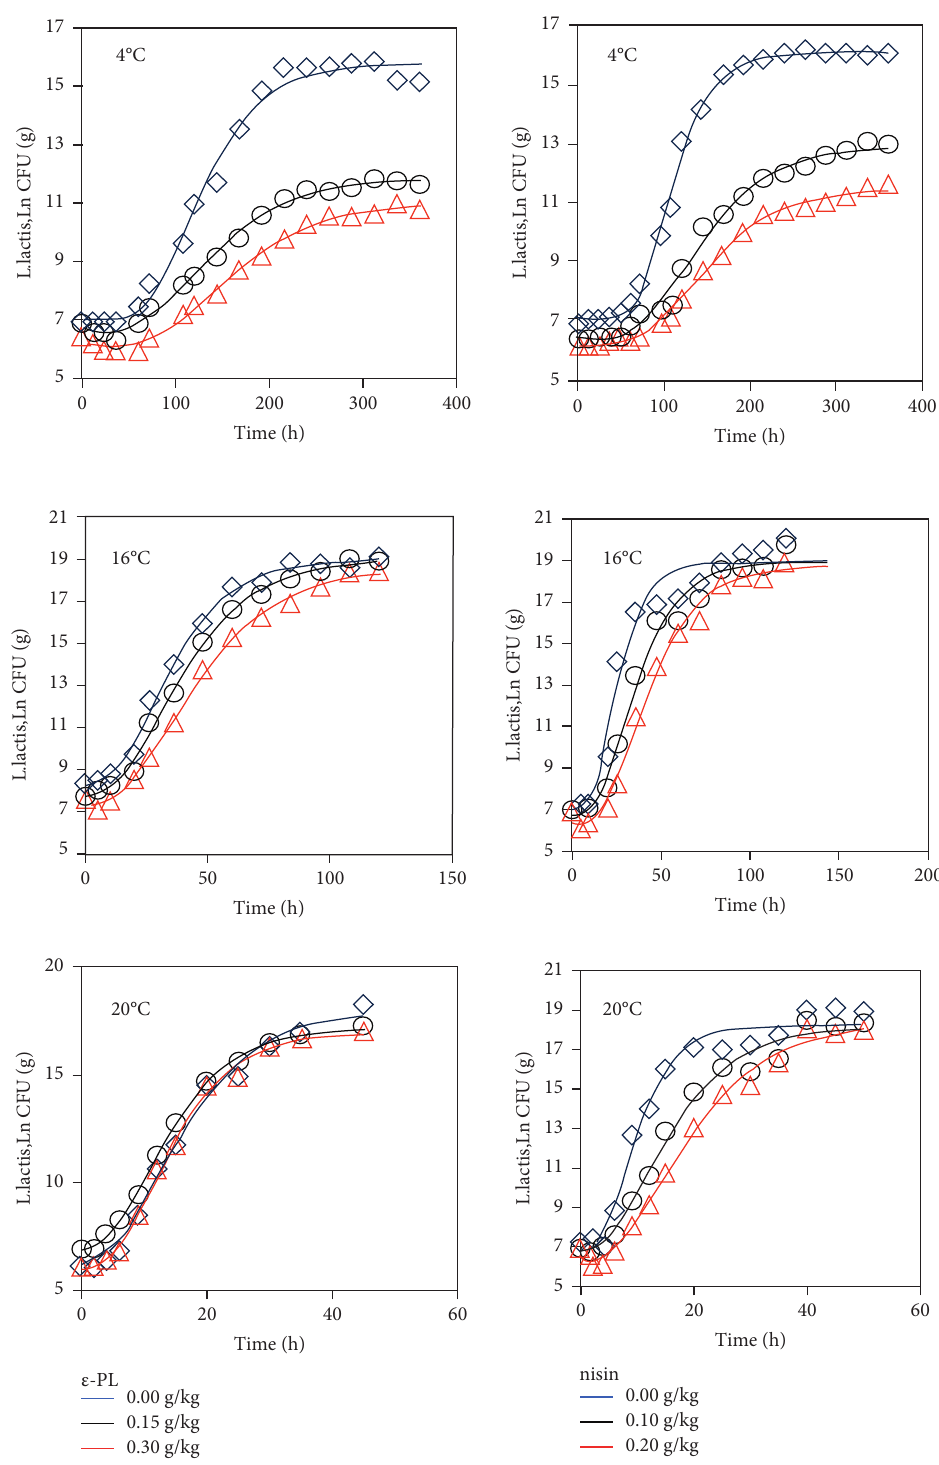
Figure 1: Growth of L. lactis in FVFB and curve-fitting at 4, 16, and 20 ° C: (a) ε -PL treated and (b) nisin treated. Solid line: reparameterized Gompertz model; symbol: observed growth